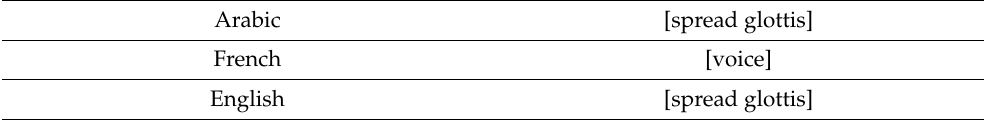
Table 4. Laryngeal features.